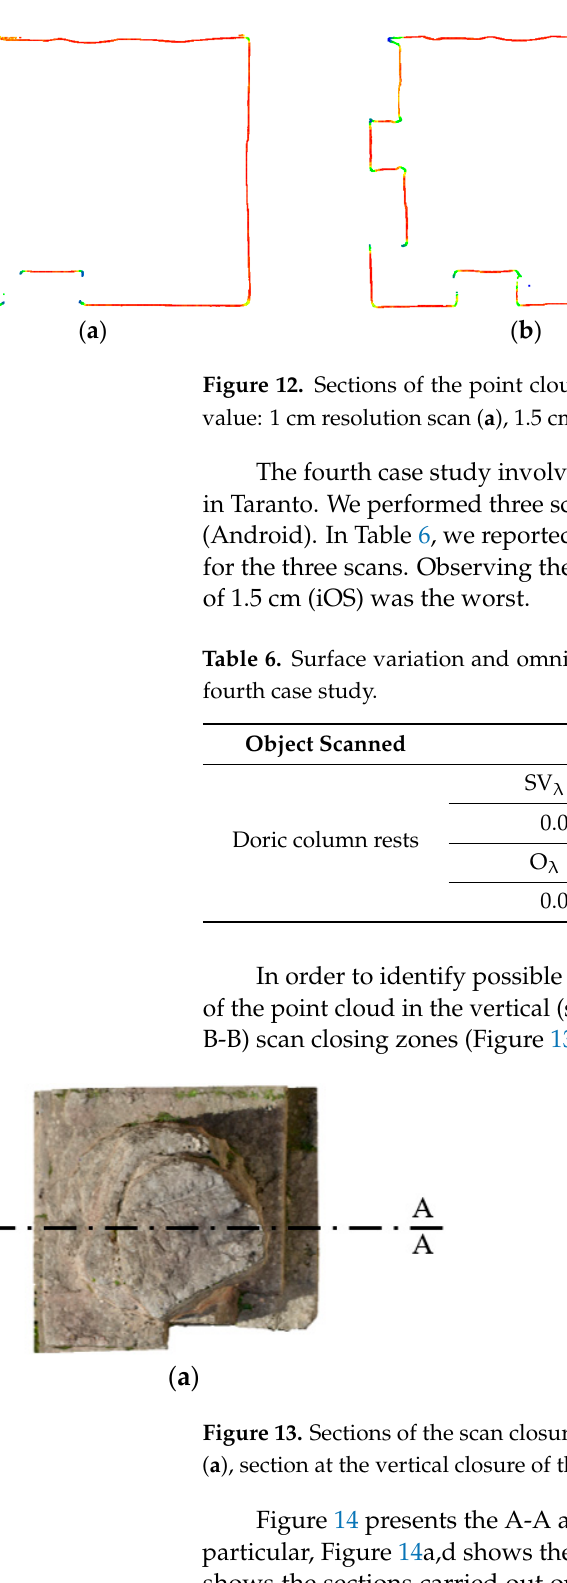
( c ) Figure 11. Sections of the point clouds of the statue scanned at distance of 3 m; the scalar field refers to the surface variation value: section of stem of statue ( a ), vertical section C-C of the statue in the scan closure zone ( b ), top view of the statue and indication of the vertical section C-C ( c ). Table 5 shows the surface variation and planarity values for the third case study. Figure 12 shows the room planimetry obtained by dissecting the point clouds at a height of approximately 1.50 m (the scalar field represents the planarity values). Looking at the planarity values in the table, it can be seen (see Figure 12) that the Android device per- formed unsatisfactorily for geomatics purposes. The iOS values, on the other hand, were quite encouraging for the scans performed at both 1 and 1.5 cm. Table 5. Surface variation and planarity values of the point cloud of the lab. room, third case study.